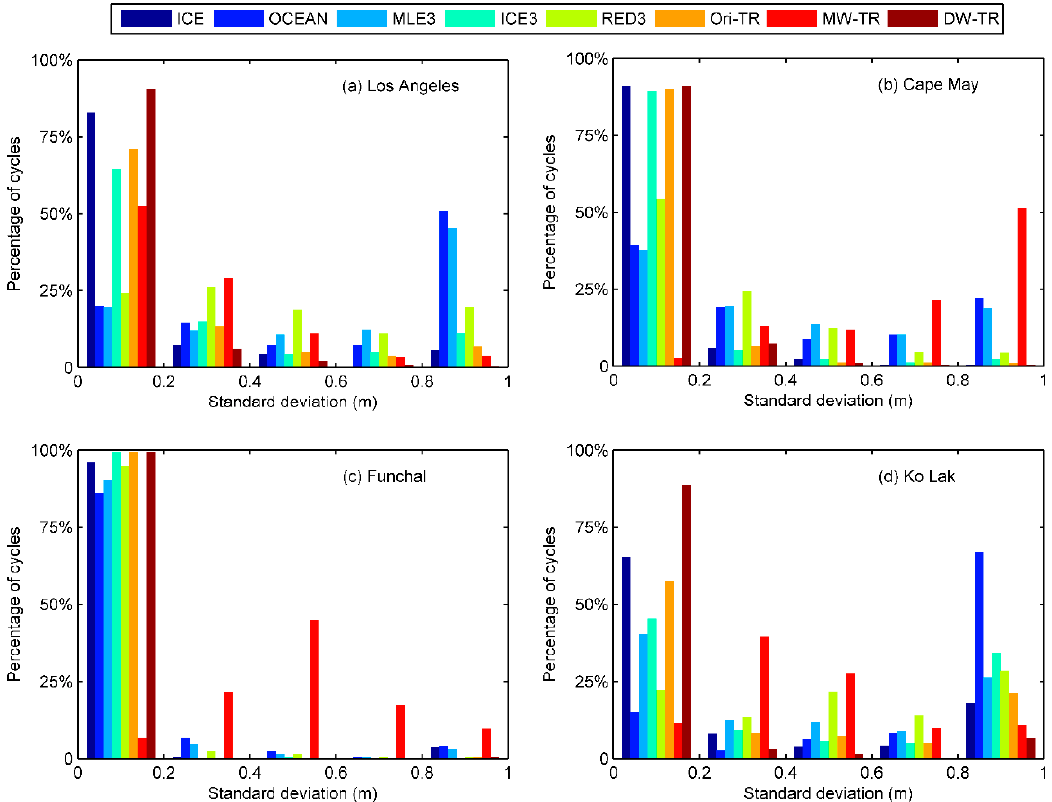
Figure 4 . Histograms for standard deviations of various retracked sea surface heights (SSHs) relative to geoid in four study regions: ( a ) Los Angeles, ( b ) Cape May, ( c ) Funchal, ( d ) Ko Lak. All available cycles are included for statistical analysis. Only frequencies of standard deviations less than 1 m are plotted with the step of 0.2 m. Retrackers are represented by different colors shown in the upmost legend.